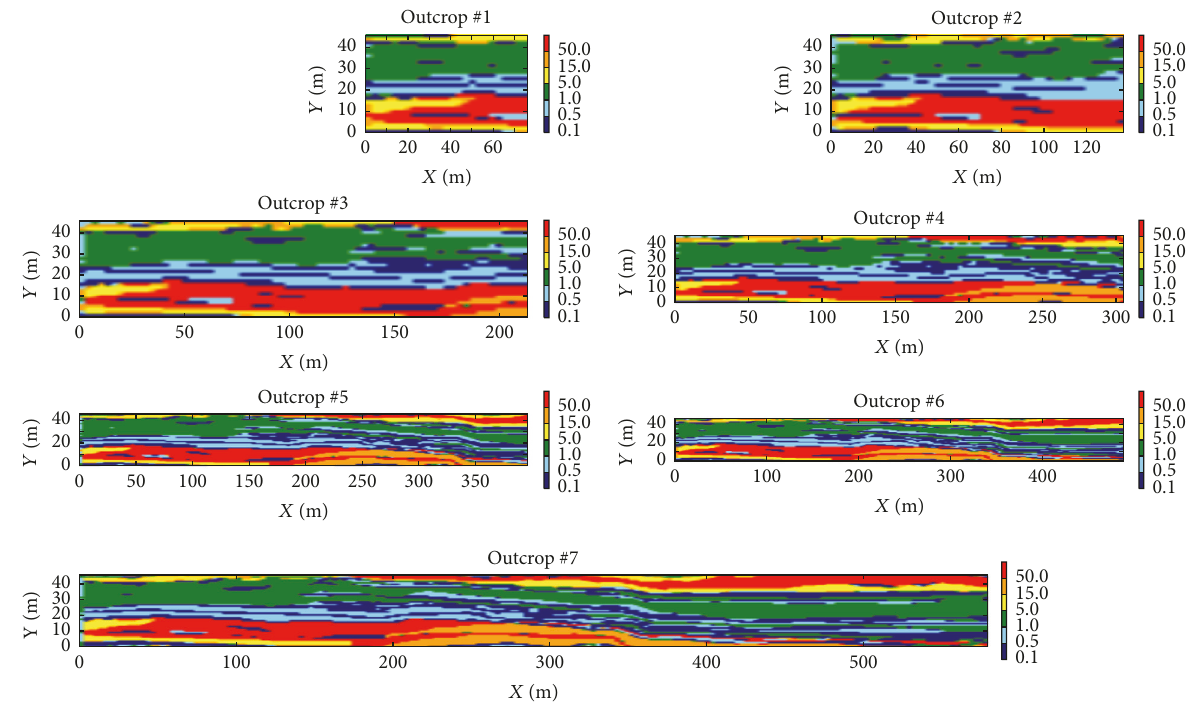
Figure 4: Map of 𝑥 -direction permeability (md) for seven outcrops at field scale [78, 79].